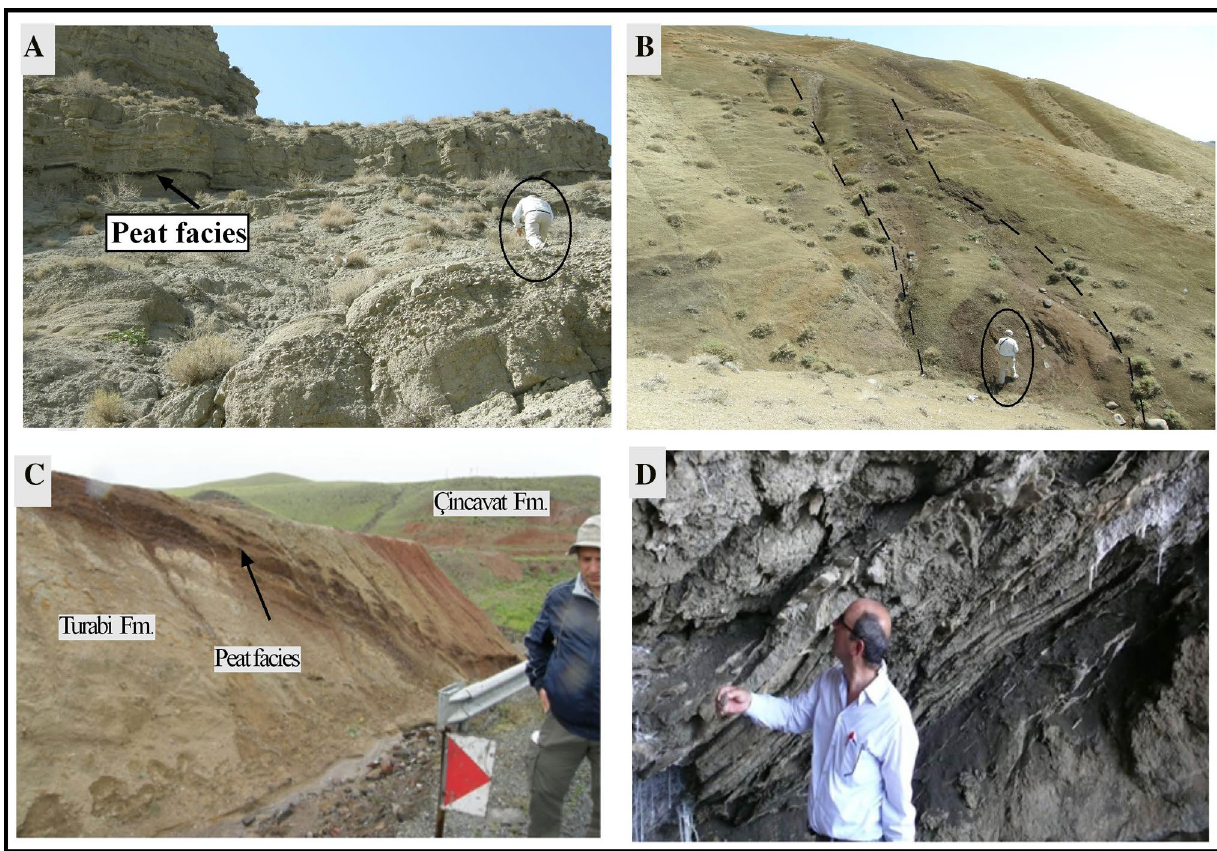
Fig. 5 a Small fan delta clastics bearing peat facies at the Halıkışlak section, b panoramic view of organic rich mudstone and thick peat facies within the Turabi Formation, c close view of peat and mud-